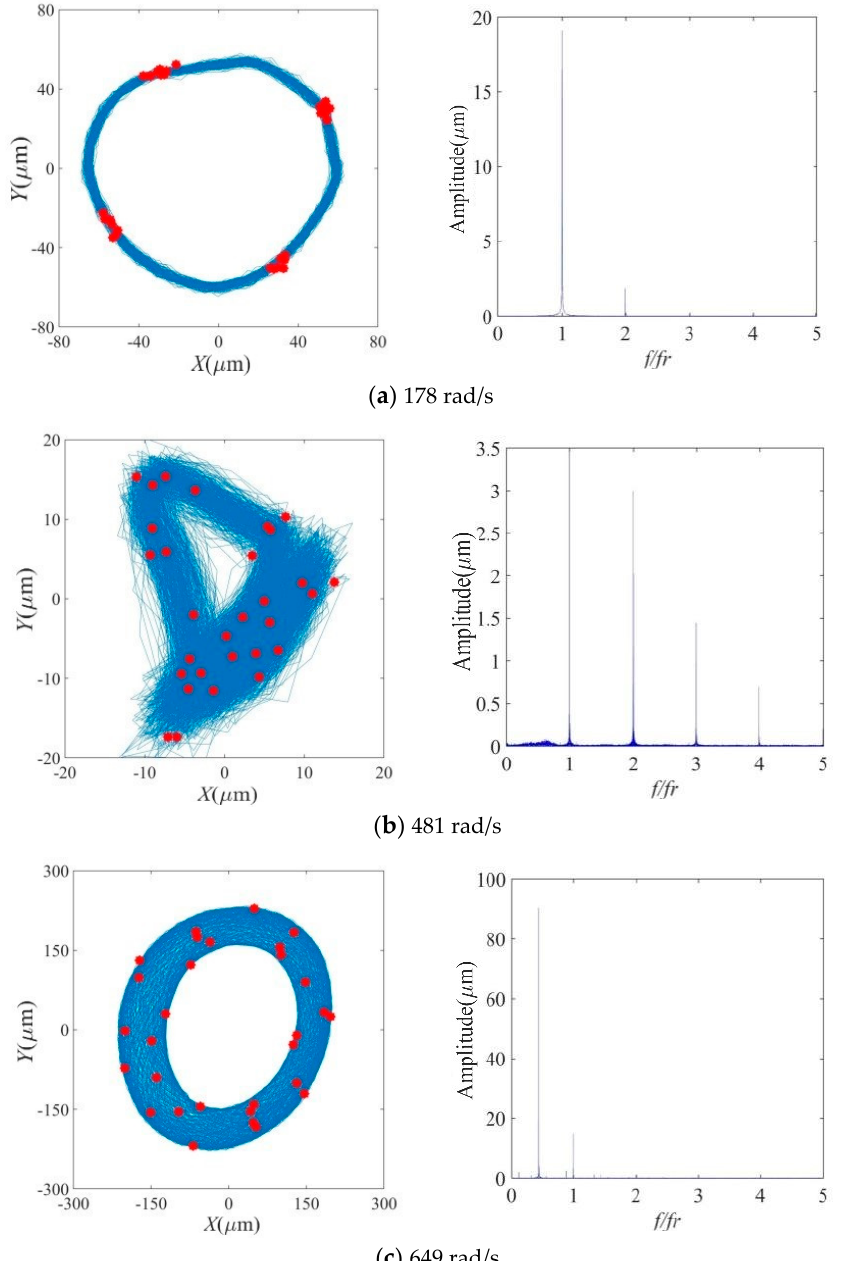
Figure 21. Trajectory of shaft center with the Poincaré map ( left side ) and the power spectrum ( right side ) for the rotating shaft at different rotating speeds and oil pressure of 1.2 MPa.